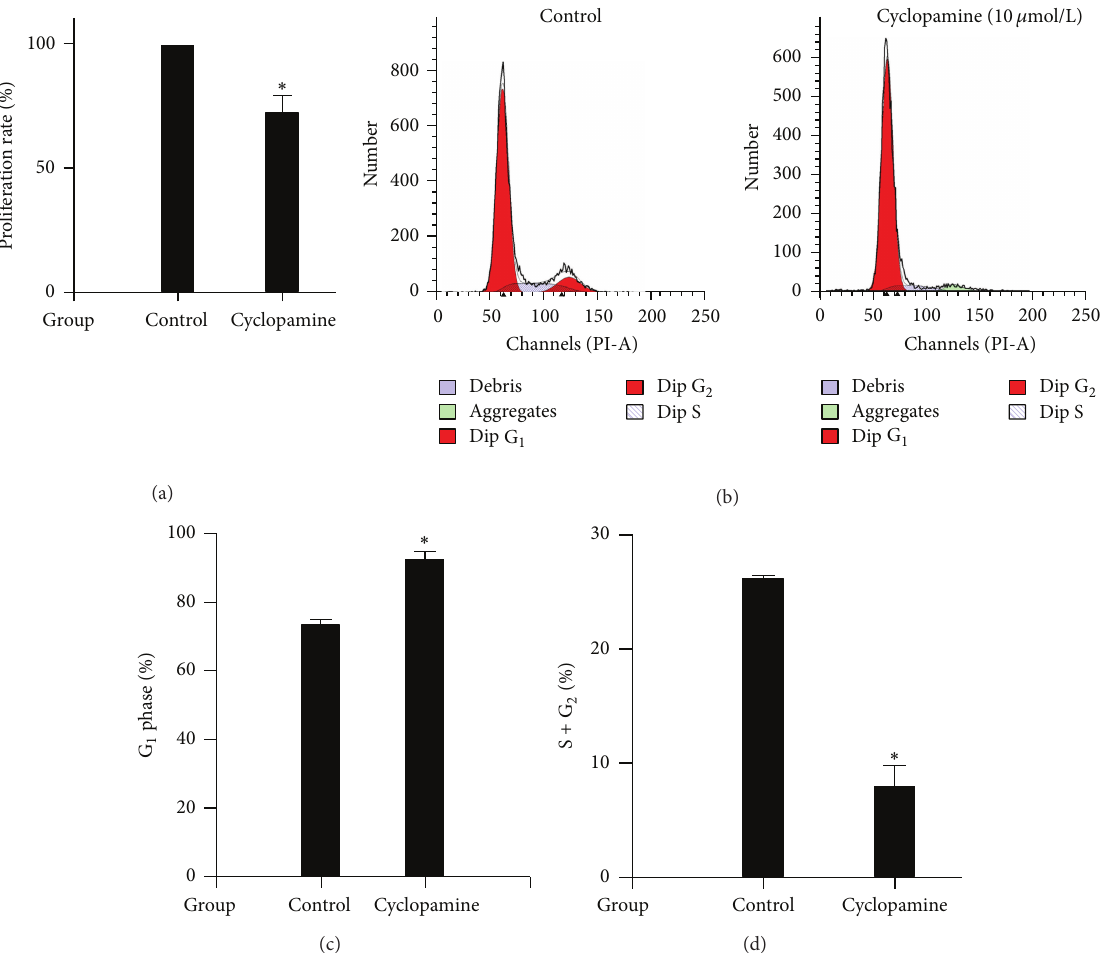
Figure 7: Cyclopamine decreased the viability of cultured FLS from RA patients. Cells were stimulated, treated, and harvested as described in Section 2. (a) Cell proliferation was determined using the Cell Counting Kit-8. The cell proliferation rate in cyclopamine-treated FLS was significantly lower than that in the control group ( 100 ± 0 )% ( ∗ 𝑃 < 0.05 ) ((b), (c)). The proportion of cells in the G 1 phase was significantly higher in cyclopamine-treated FLS than in controls, indicating cell cycle arrest ( ∗ 𝑃 < 0.05 ). (d) In cyclopamine-treated FLS the percentage of cells in the S + G 2 phase was significantly reduced, indicating inhibition of cell proliferation ( ∗ 𝑃 < 0.05 ). Results in (a), (c), and (d) show the means ± S.D. of three independent